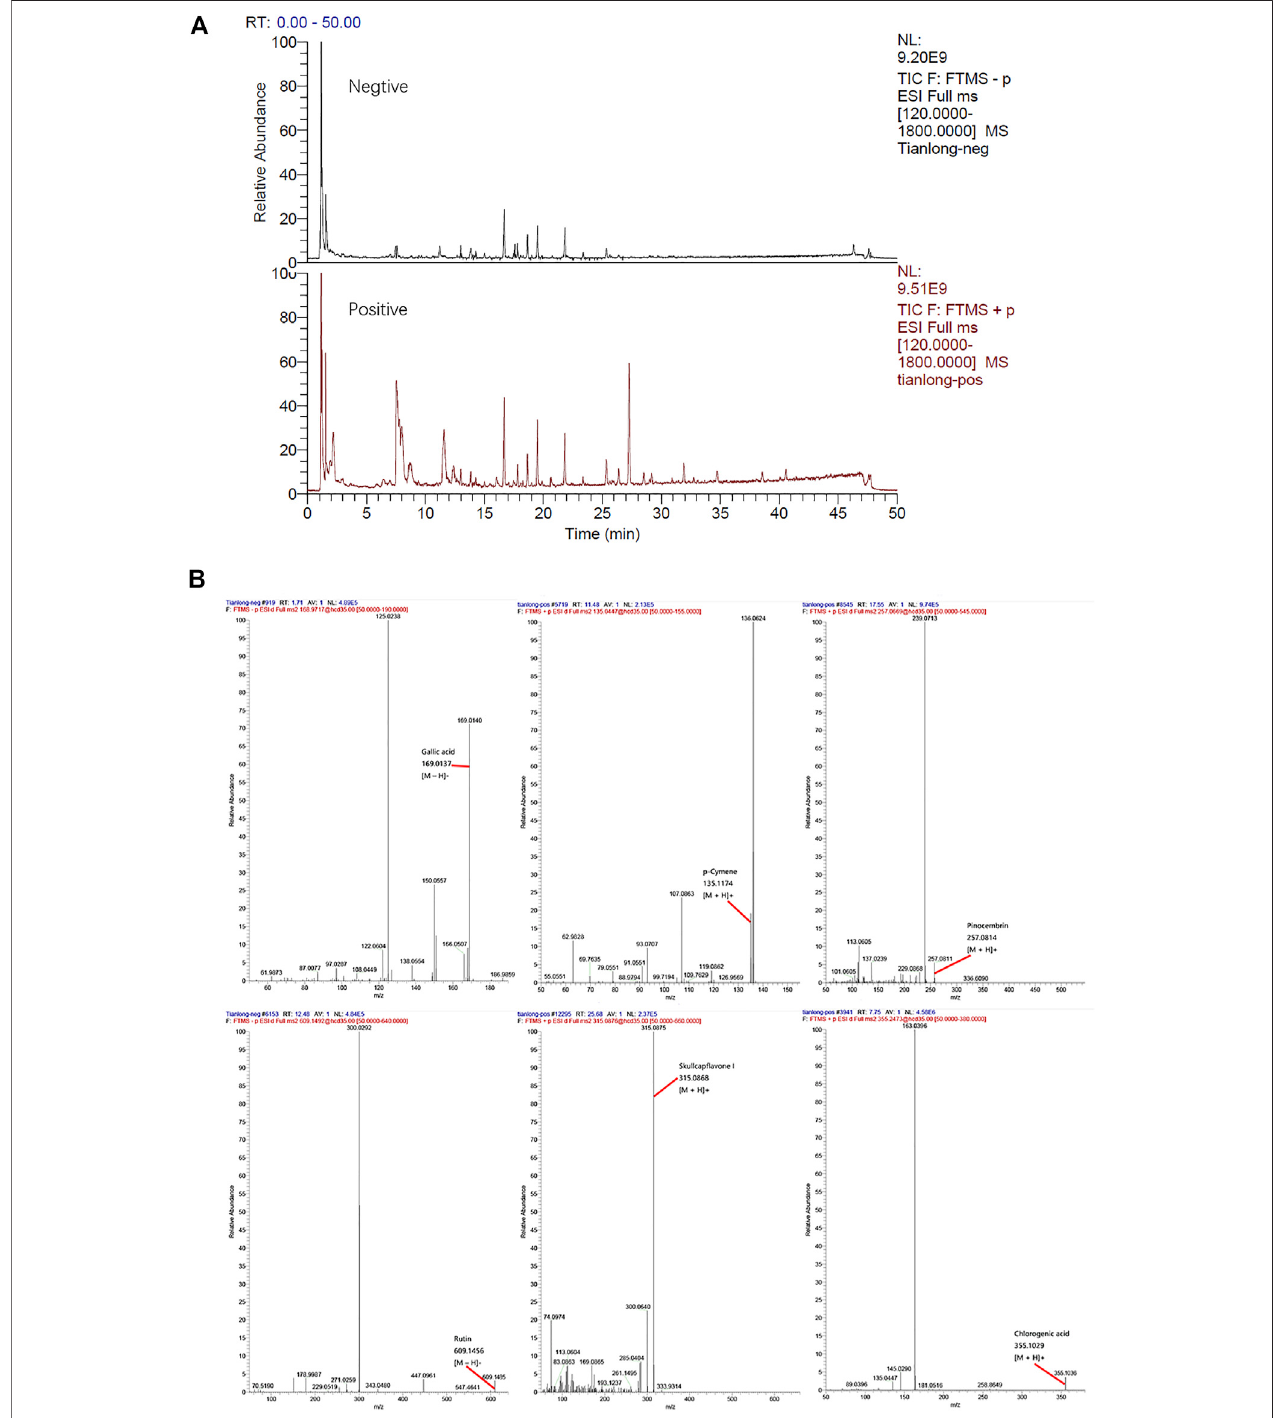
FIGURE 1 | (A) Total ion chromatogrm monitored in positive and negative ion modes for TL extract (B) TL extract composition analysis: TL has Gallic acid, p -Cymene, Pinocembrin, Rutin, Skullcap fl avone I, Chlorogenic acid, and other ingredients.